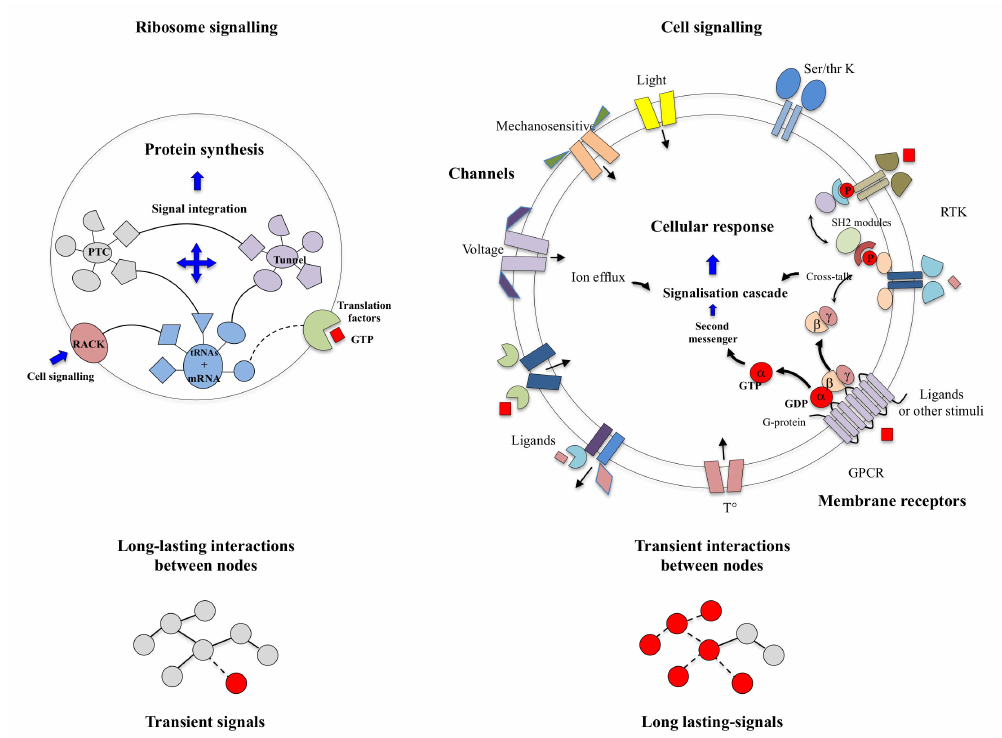
Figure 6. Comparison of ribosome and cell signalling. ( Left ) Long-lasting interactions between network nodes (ribosomal proteins and functional centres) in the ribosome are suitable for the propagation of ephemeral signals. ( Right ) Transient interactions between nodes in cell signalling impose the development of long-lasting diffusible signals (post-translational modification or synthesis of second